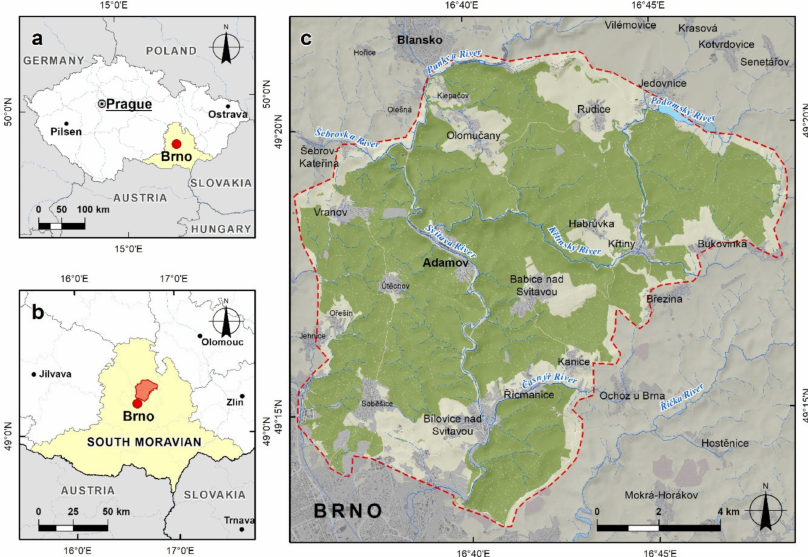
Figure 2. Location of study area. Overview maps of the ( a ) national and ( b ) regional context. ( c ) Forest area managed by University Forest Enterprise